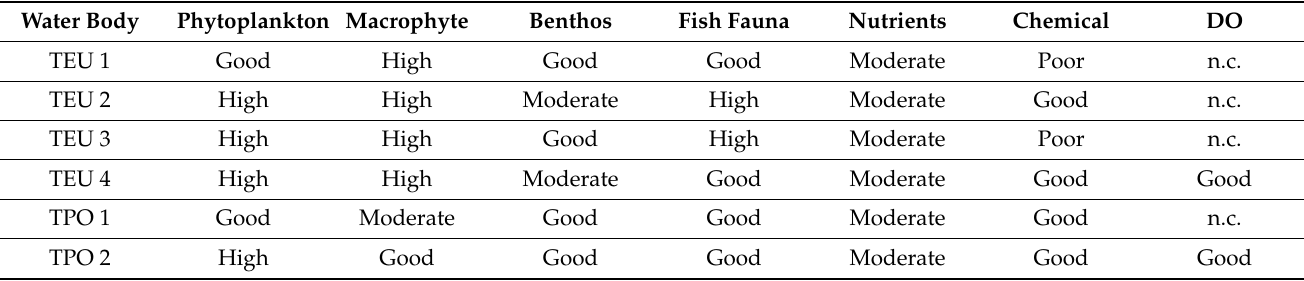
Table 3. Classification of the Marano and Grado Lagoon water bodies sensu WFD (2017–2019). The notation n.c. means not